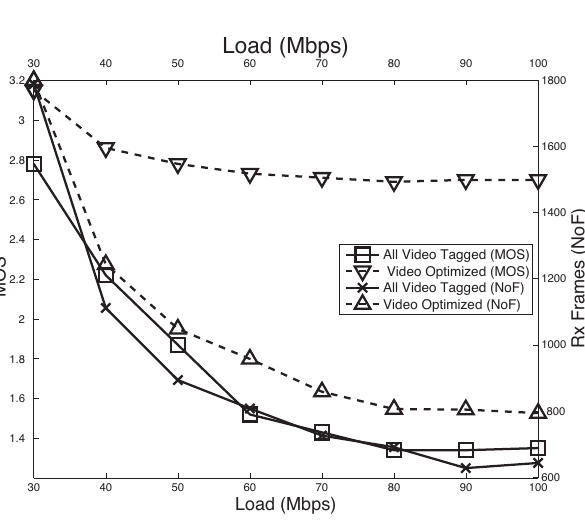
Figure 14. Comparison between MOS and Number of Received Frames with Video Optimization